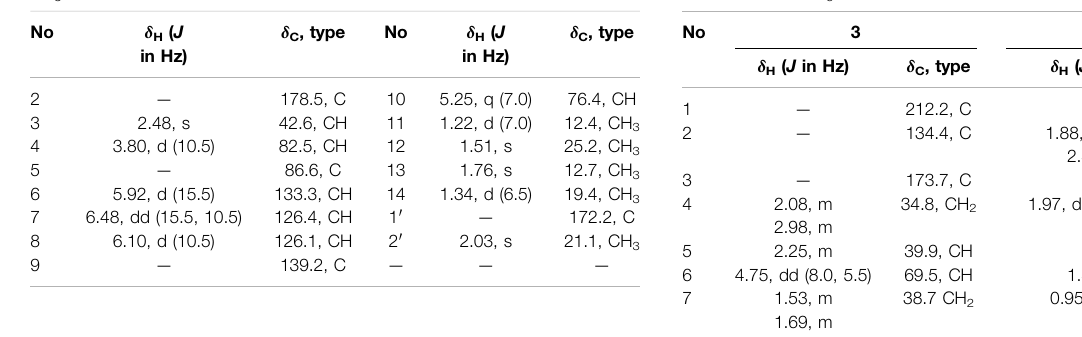
TABLE 1| 1 H(500 MHz)and 13 C(125 MHz)NMRspectral dataofcompound 1 in CD